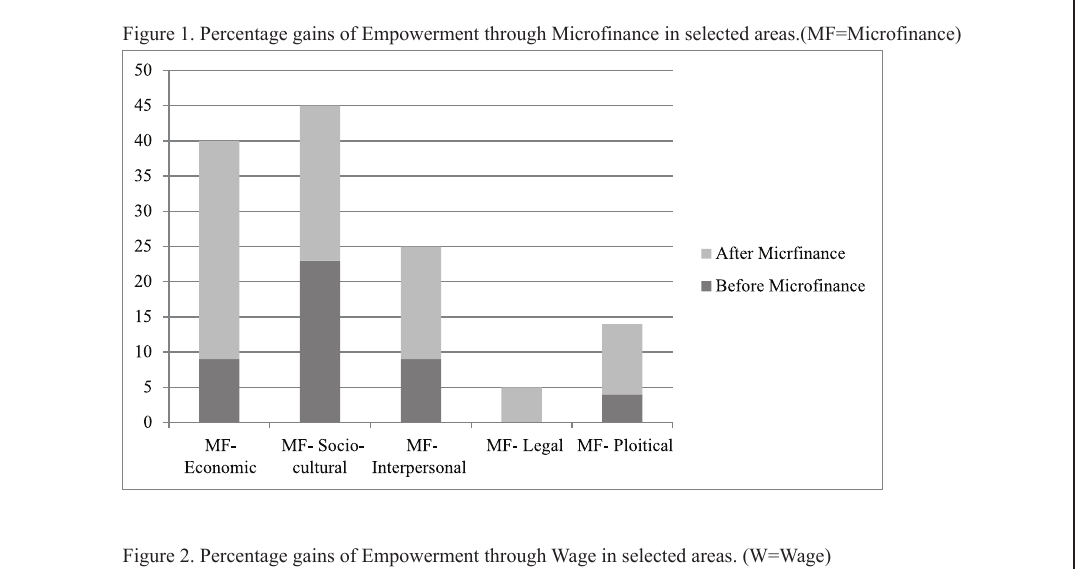
Figure 1. Percentage gains of Empowerment through Microfinance in selected